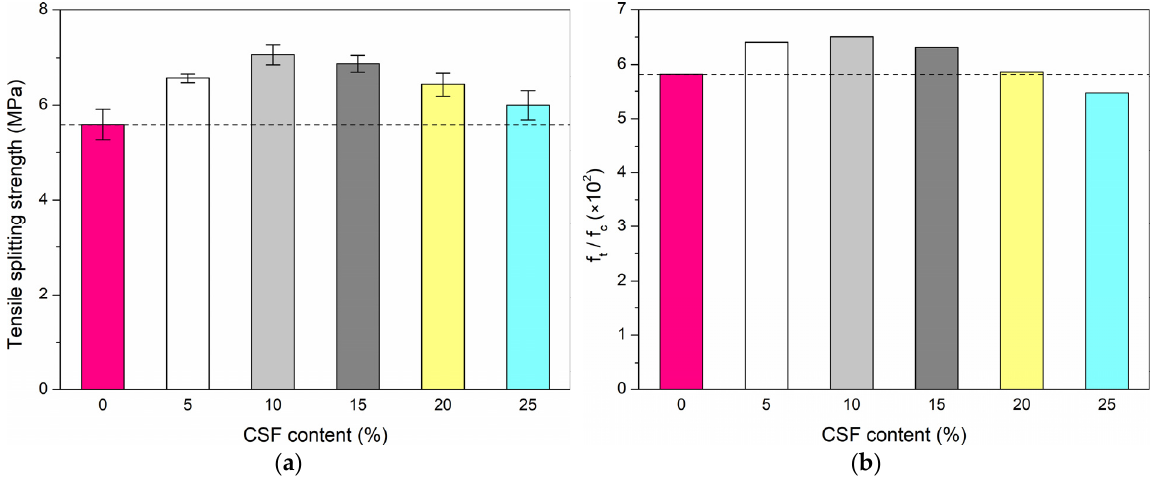
Figure 4. Differences in ( a ) tensile splitting strength; ( b ) ratio of split tensile strength to compressive with CSF replacement.